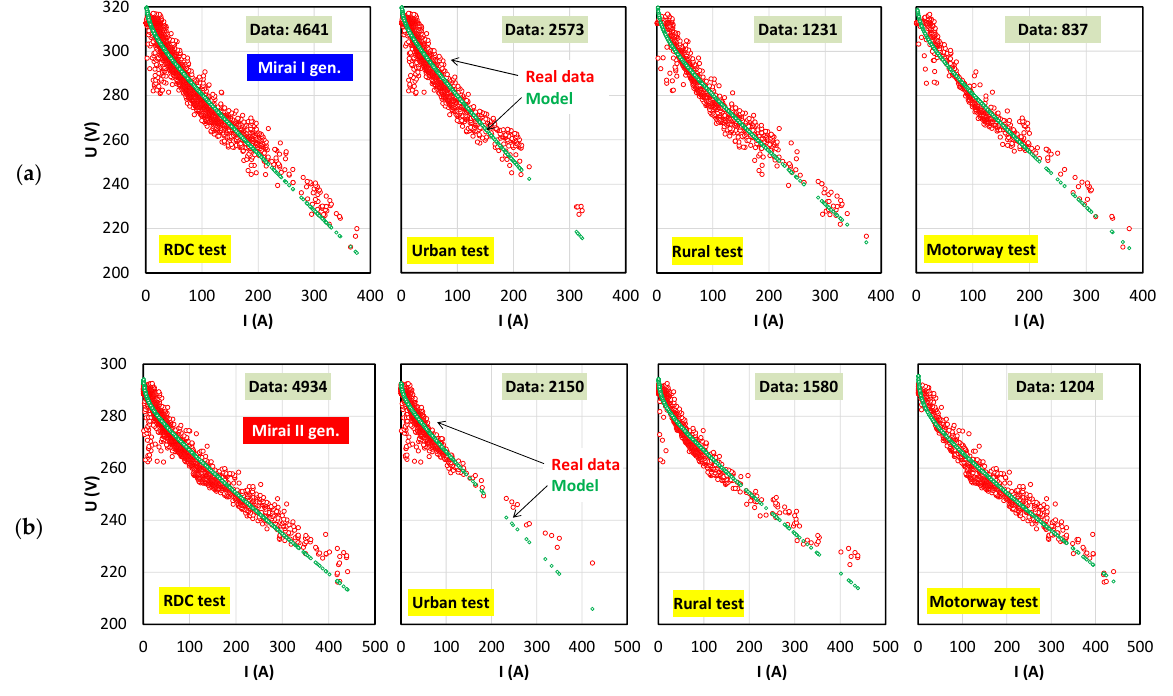
Figure 17. Current–voltage characteristics of the fuel cell stack of hydrogen-powered drives with modeling results: ( a ) I generation FCHEV drive; ( b ) II generation FCHEV drive.